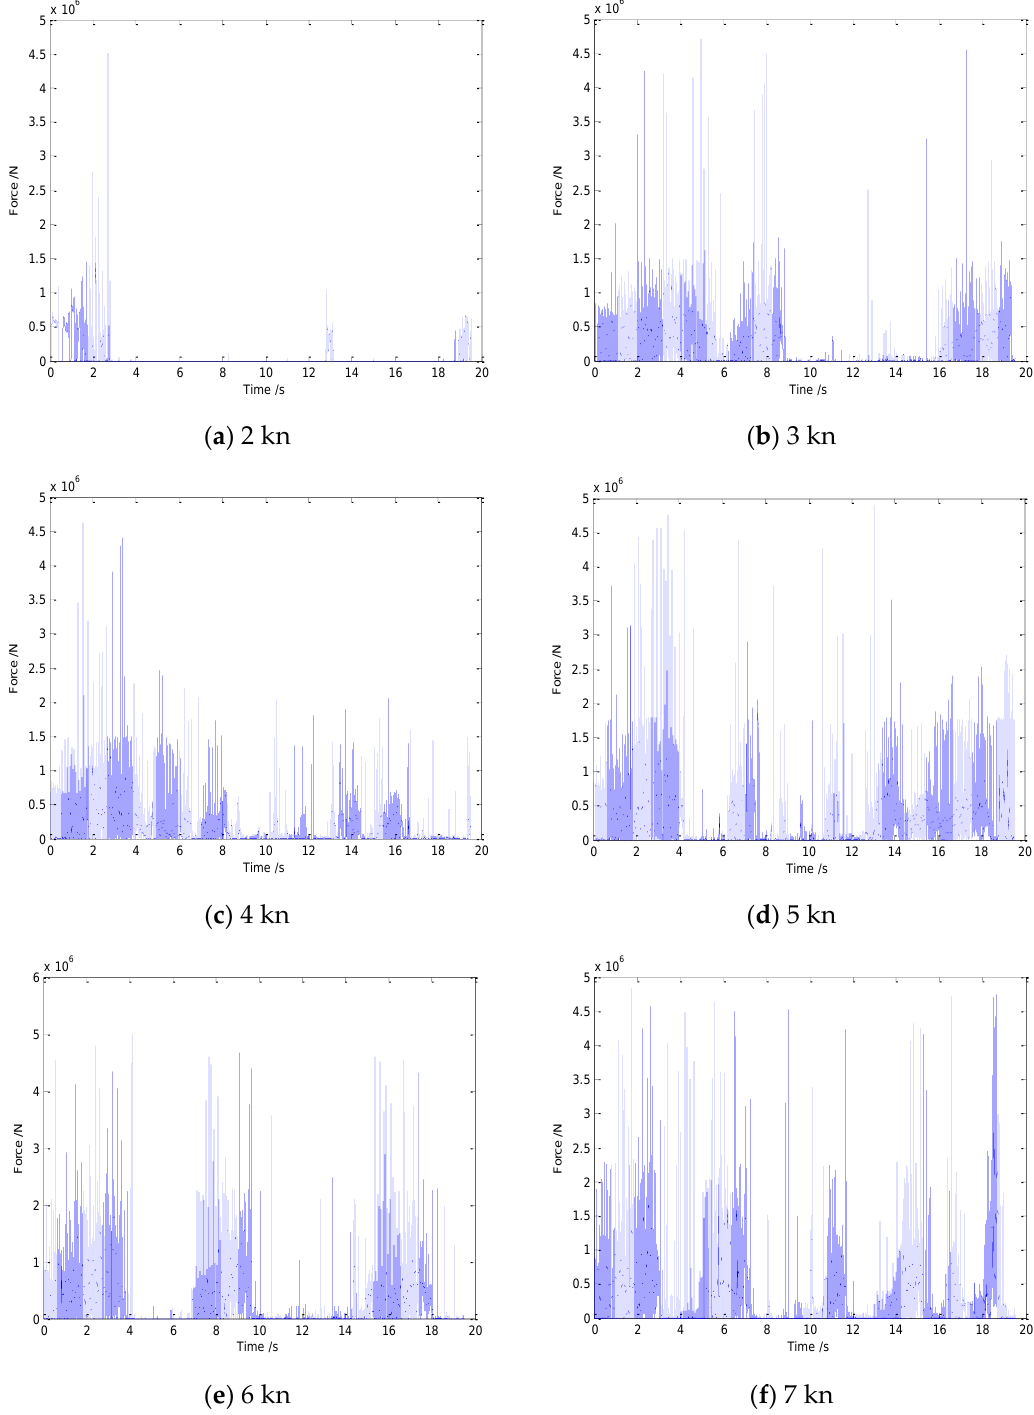
Figure 13. Time history of ice load with different ship velocity.